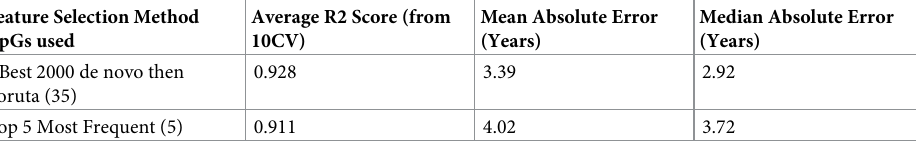
Table 4. Results of the two models created from the Horvath down syndrome blood dataset (GSE52588) [22] using the same CpGs selected from the two feature selection methods from the initial Hannum experiment. These models were validated using the same 10CV scheme from the initial Hannum experiment. Number of CpG sites/fea- tures in parentheses. Feature Selection Method CpGs